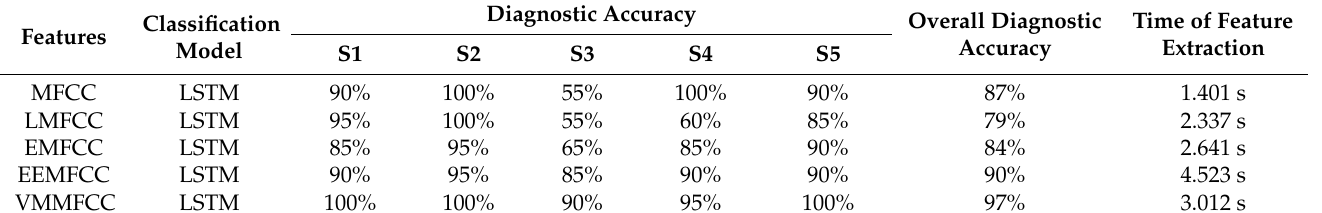
Table 7. Diagnostic accuracy of different characteristics.